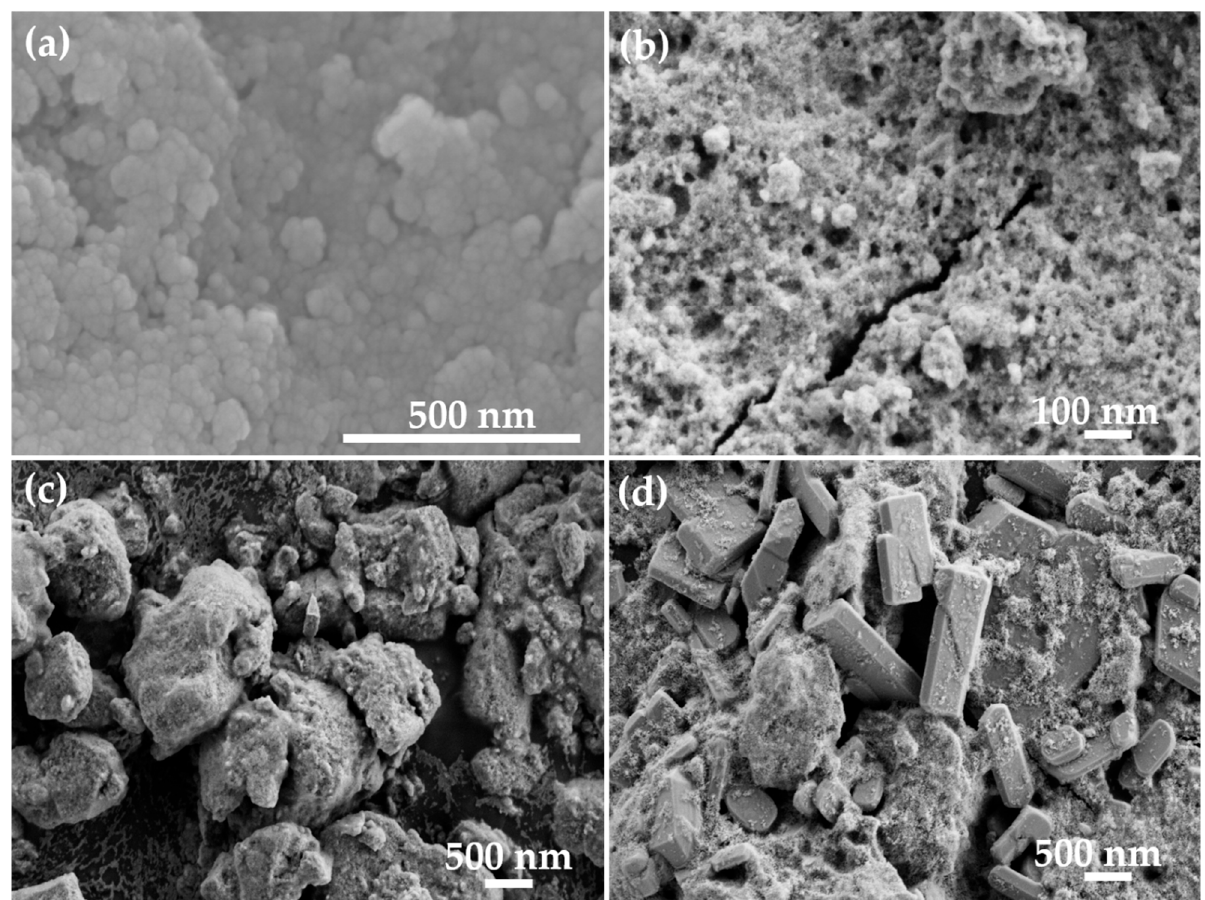
Figure 3. Typical FESEM images of pure and Cu-doped TiO 2 nanomaterials ( a ) S0, ( b ) S1, ( c ) S2, and ( d ) S3 samples.